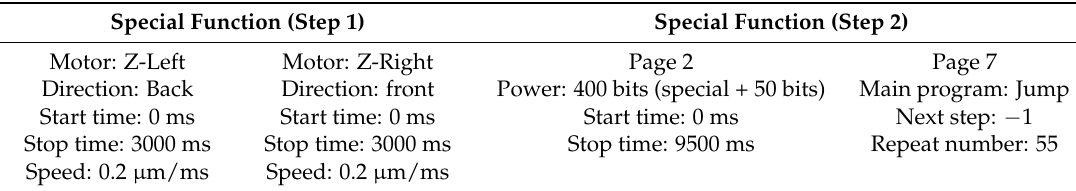
Table 1. The program for fabricating an LPFG on UHNA-7